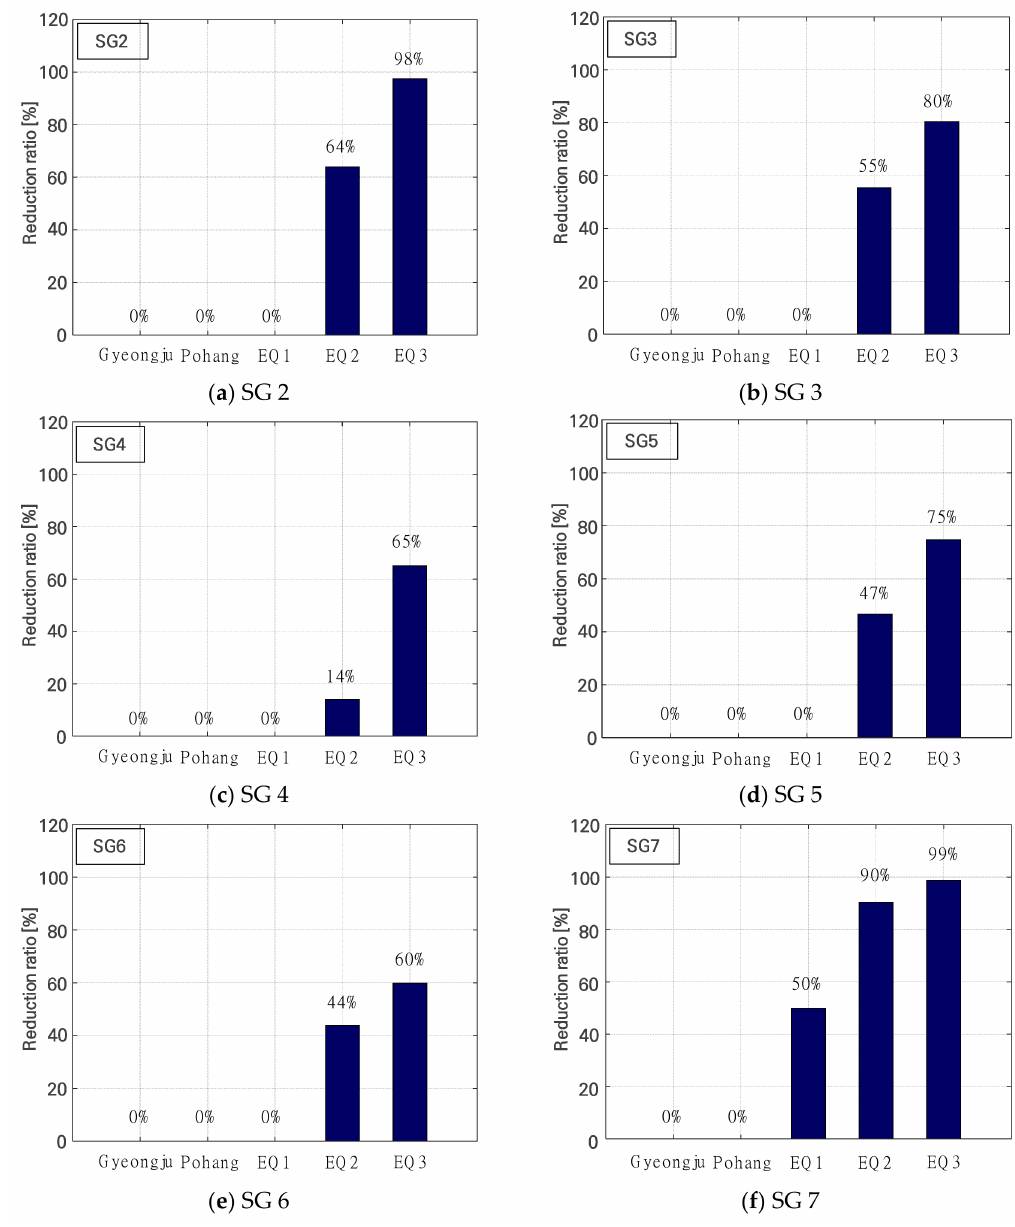
Figure 11. Permanent strain ratios (Case 2/Case